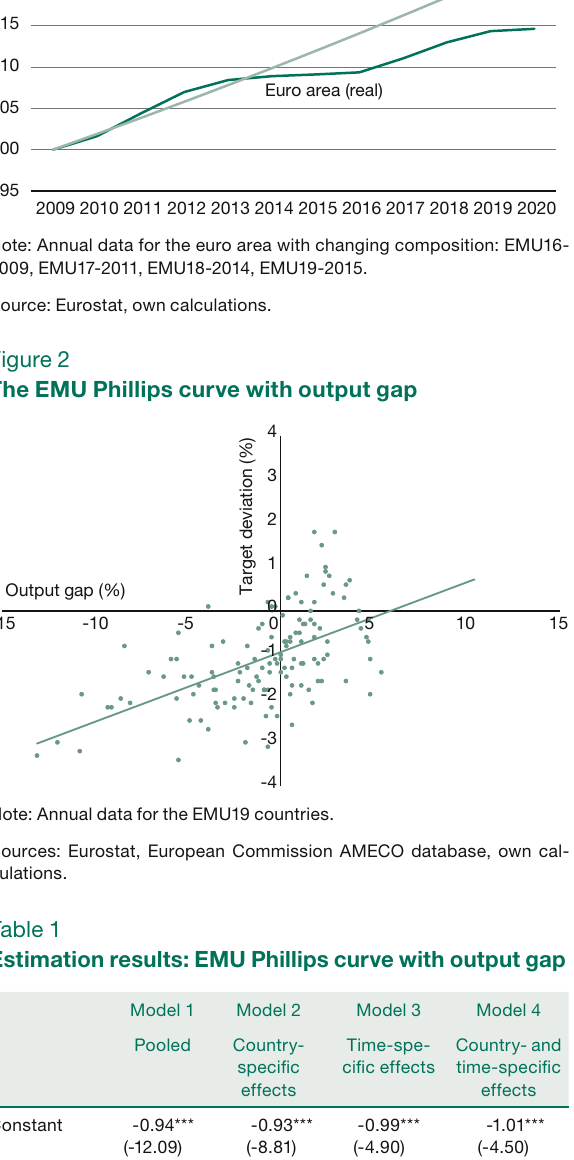
Notes: *** 99% signifi cance level; ** 95% signifi cance level; * 90% signifi - cance level; t-values in parentheses. Source: